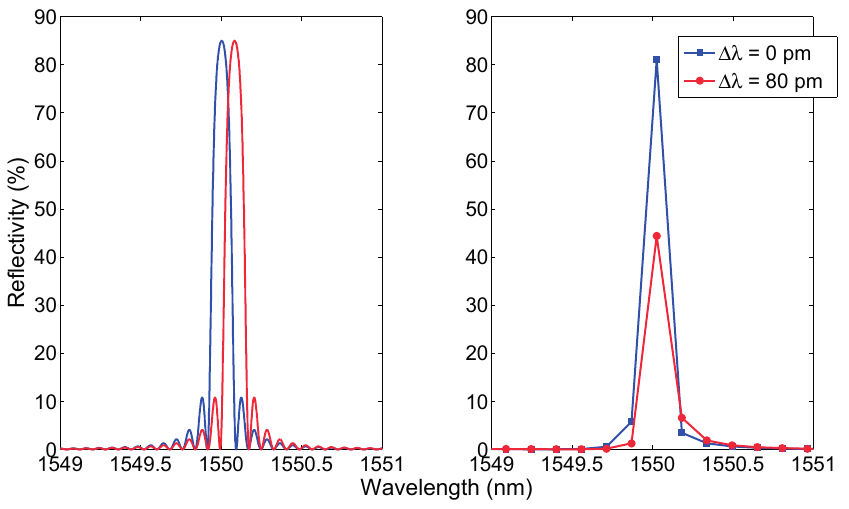
Figure 1. Benchmark for simulation of an FBG sensor. Left: original spectrum, in reference conditions ( Δλ = 0 pm) and with a wavelength shift applied ( Δλ = 80 pm). Right: reference and shifted spectra after wavelength and amplitude discretization, on a 156-pm wavelength